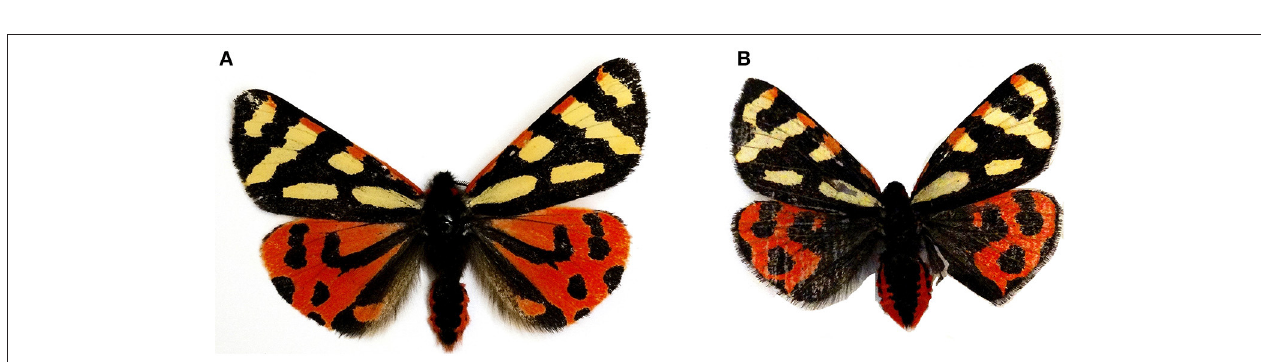
FIGURE 10 | Caucasian populations of the wood tiger moth are characterized by the lack of sexual dimorphism in hindwing colouration seen in Europe. In Georgia, both males (A) and females (B) exhibit hindwing coloration rich in long wavelengths resulting in continuous red-orange coloration. Photos: B.